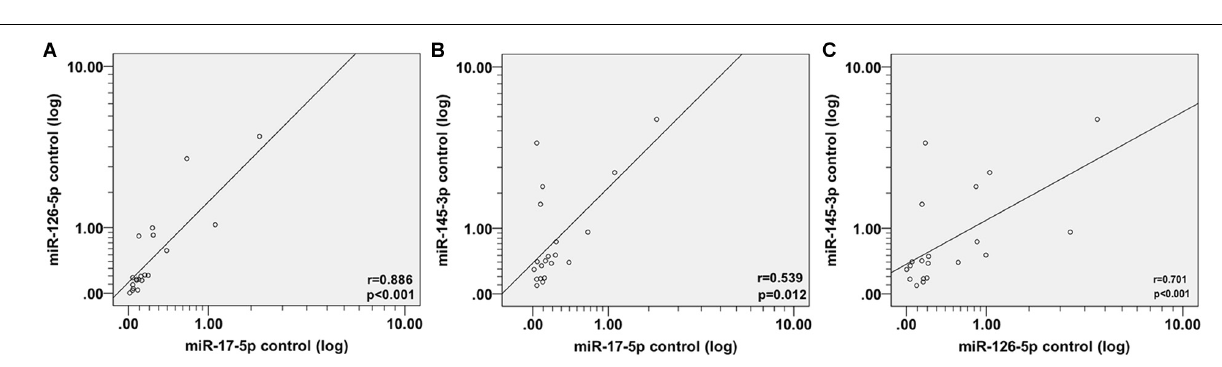
FIGURE 3 | Spearman correlations between circulating miRNAs in control subjects. The scatter plots show the marked correlation in the expression values between (A) miR-17-5p and miR-126-5p, (B) miR-145-3p, and (C) between miR-126-5p and miR-145-3p in the control ( n = 21)